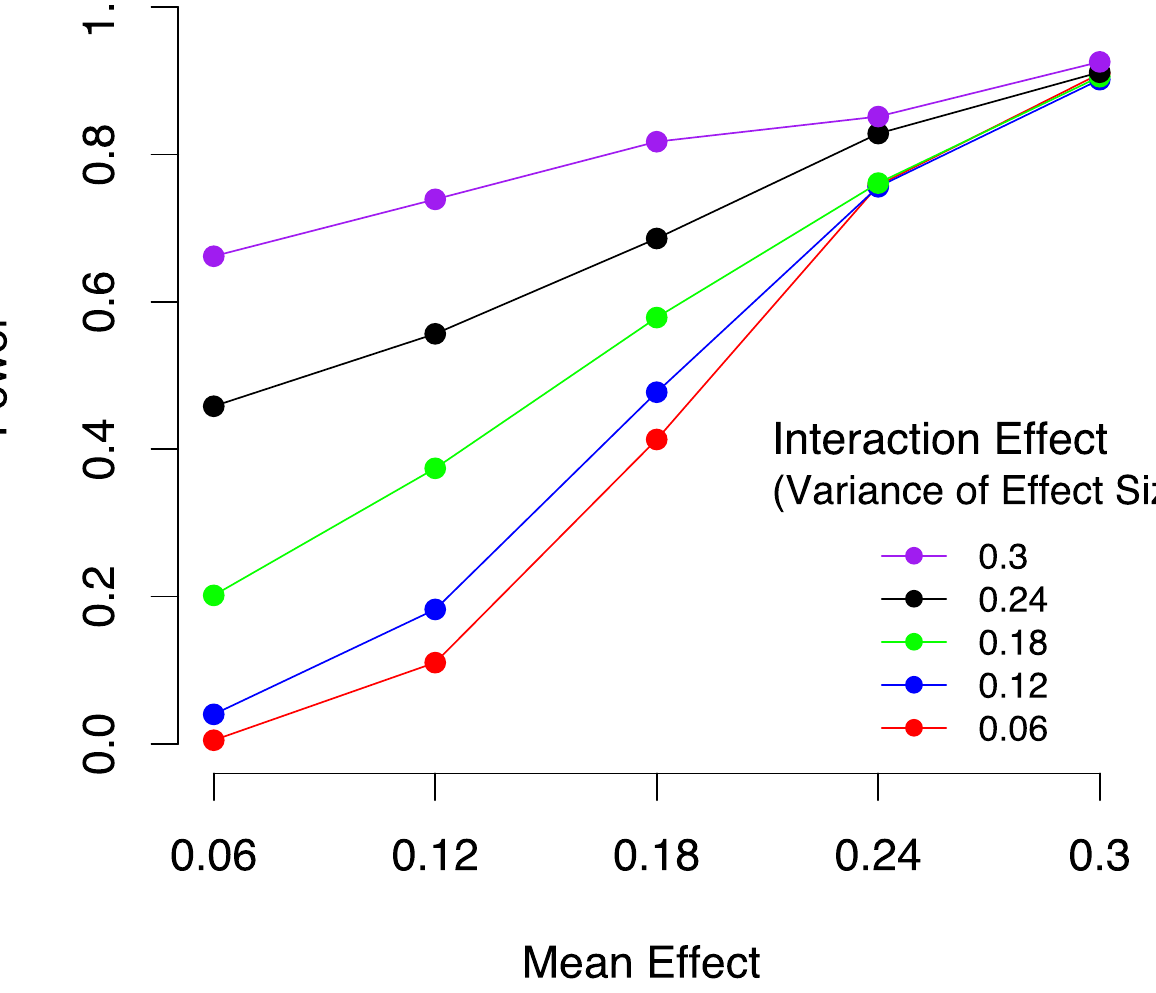
Figure 3. Power of mouse meta-analysis to identify gene-by-environment interactions in 4,965 animals from 17 studies under varying mean effect sizes and the per study variance of the effect size which corresponds to gene-by-environment